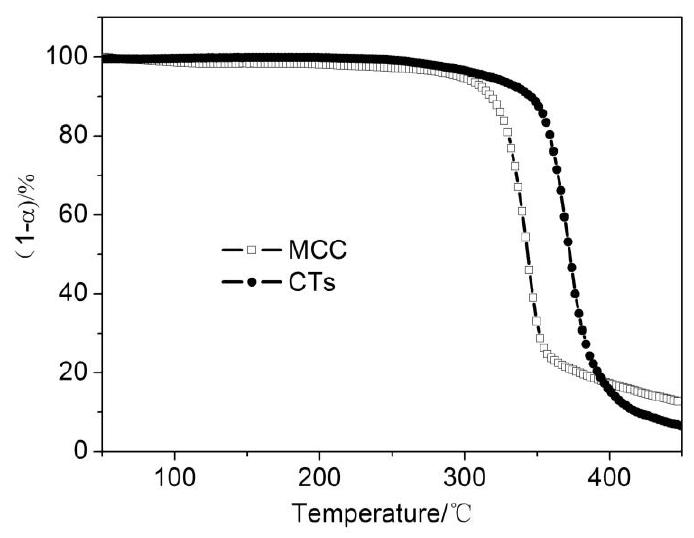
Figure 4. Thermogravimetric (TG) curves of CTs and MCC at 10 K/min.